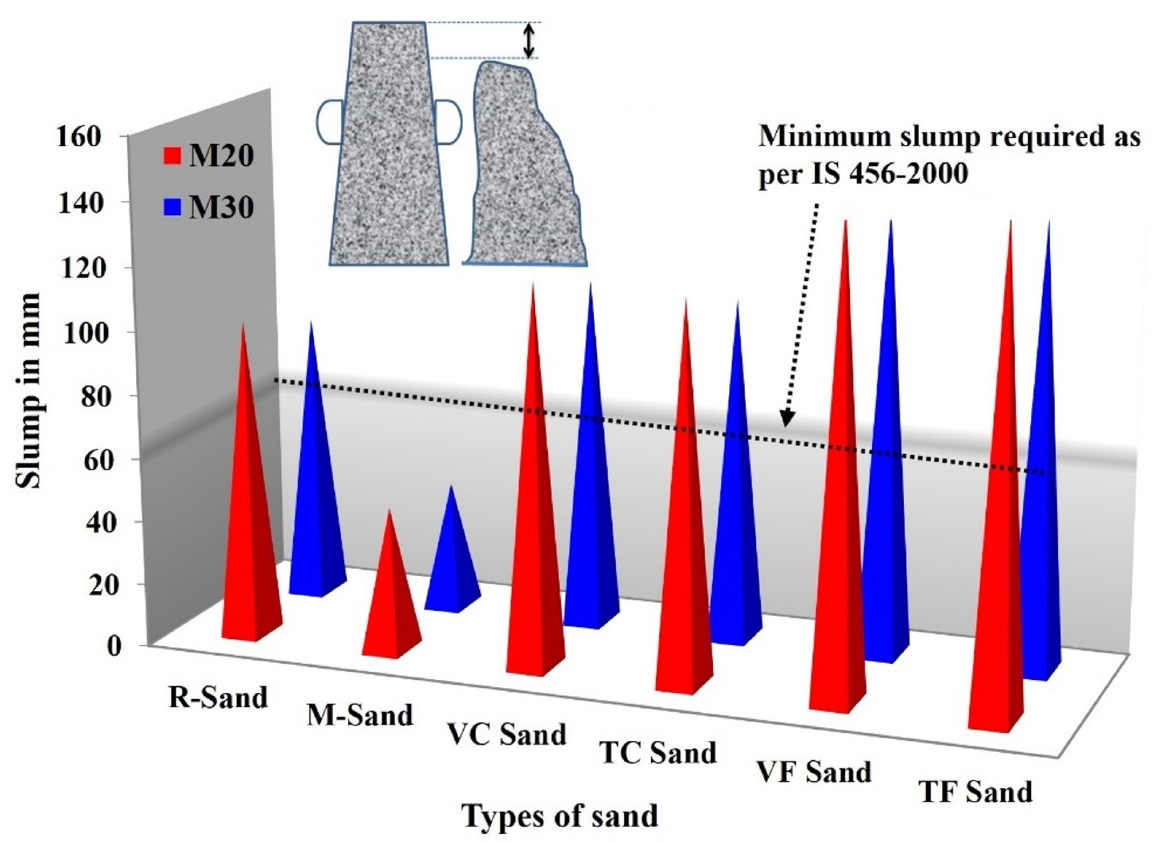
Figure 12. Slump values of M20 and M30 concrete.